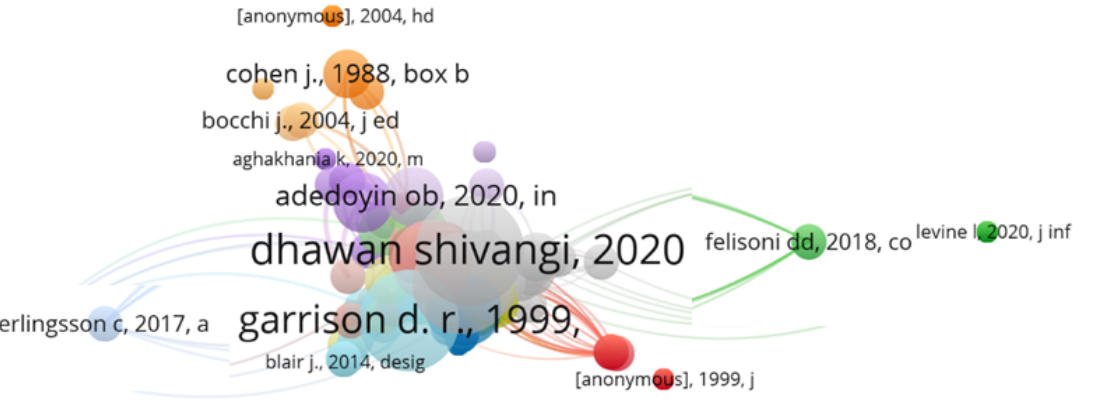
Figure 5. VOSviewer mapping of student perceptions of online education regarding co-citation/co-citation-cited sources. Source: authors’ own analysis with VOSviewer.